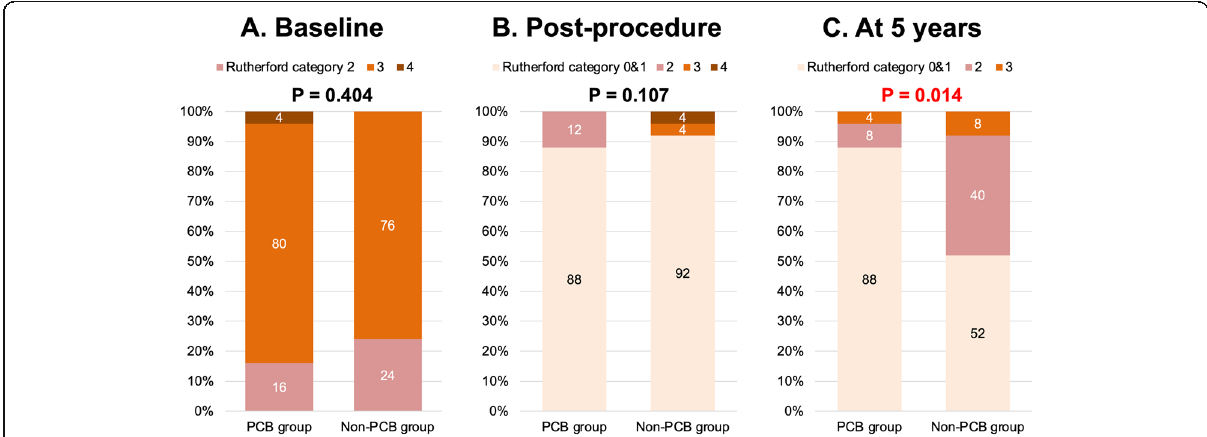
Fig. 3 Change in Rutherford Category before and after Procedure, and at 5-year Follow-up in the Matched Population. a The Rutherford categories before and b after the percutaneous transluminal angioplasty were not difficult between the PCB and non-PCB groups. c At 5 years, the rate of patients with Rutherford category 0 & 1 was significantly higher in the PCB group ( p = 0.014). PCB indicates paclitaxel-coated